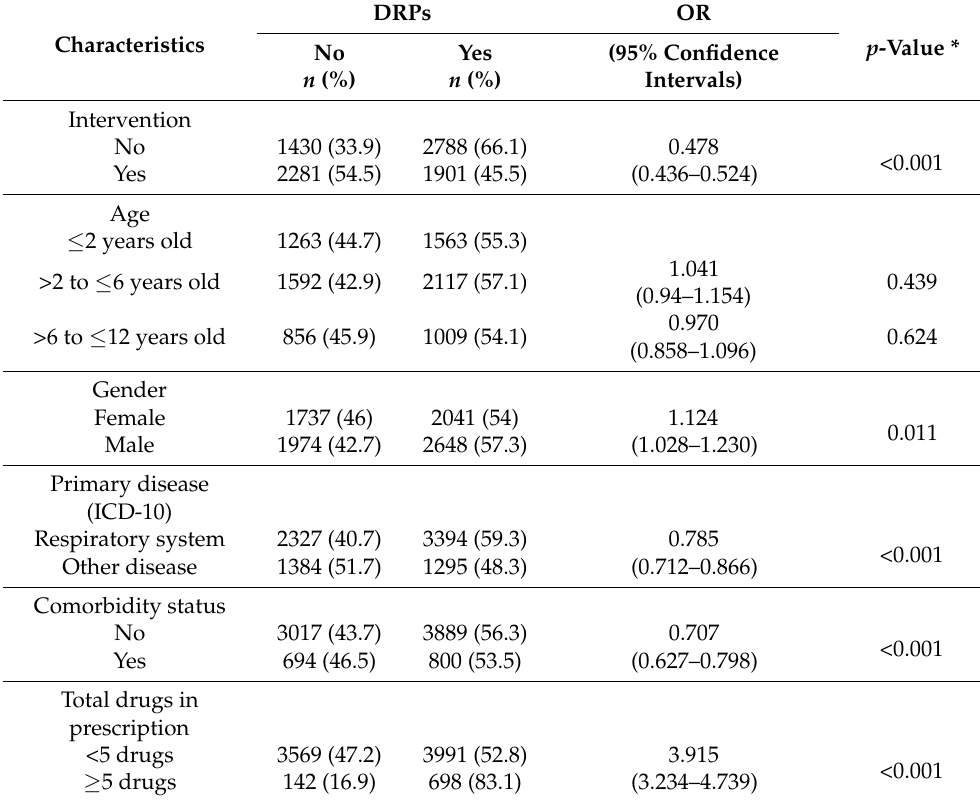
Table 4. Risk factors associated with the occurrence of drug-related